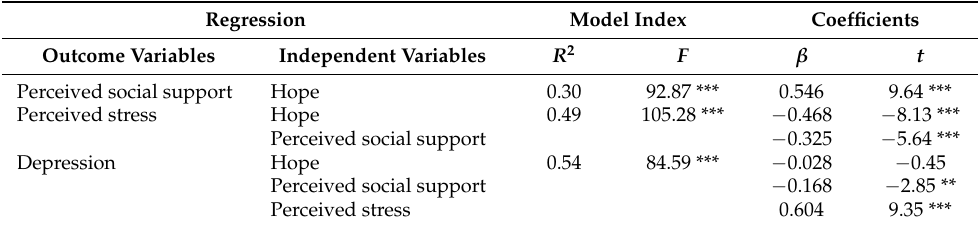
Table 3. Regression analysis results.